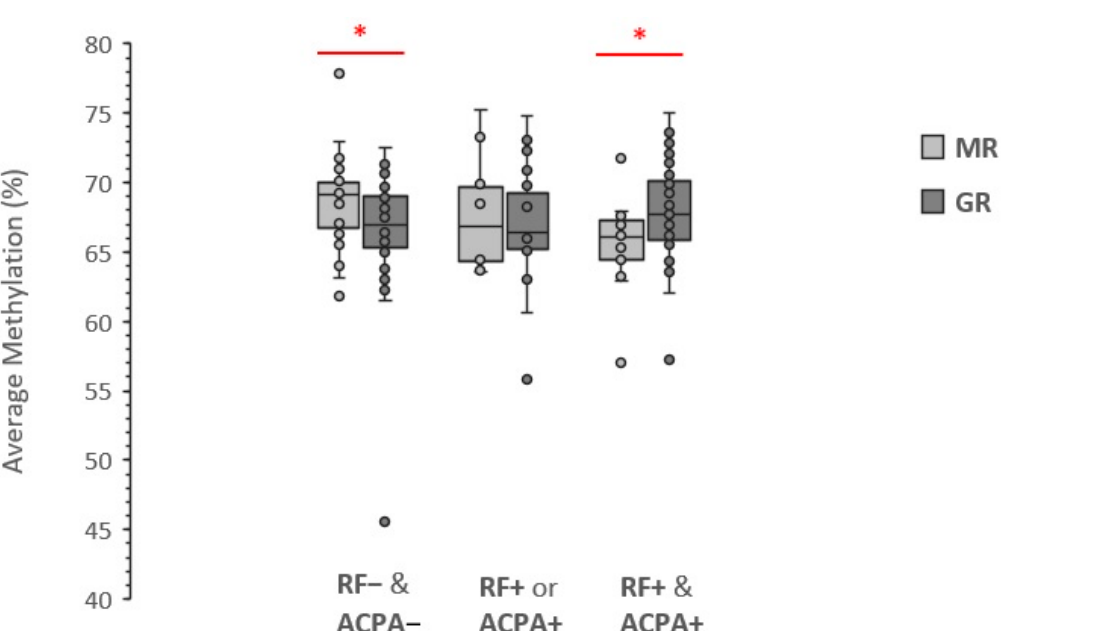
Figure 4. Effect of seropositivity on the association between LINE-1 methylation level and the magnitude of response to MTX therapy. Data are presented as the average methylation percentage of five CpG sites. FR − & ACPA − : seronegative; FR − or ACPA − : single positive; FR+ & ACPA+: double-positive; MR, Moderate Response; GR, Good Response; * significant nominal p -value.